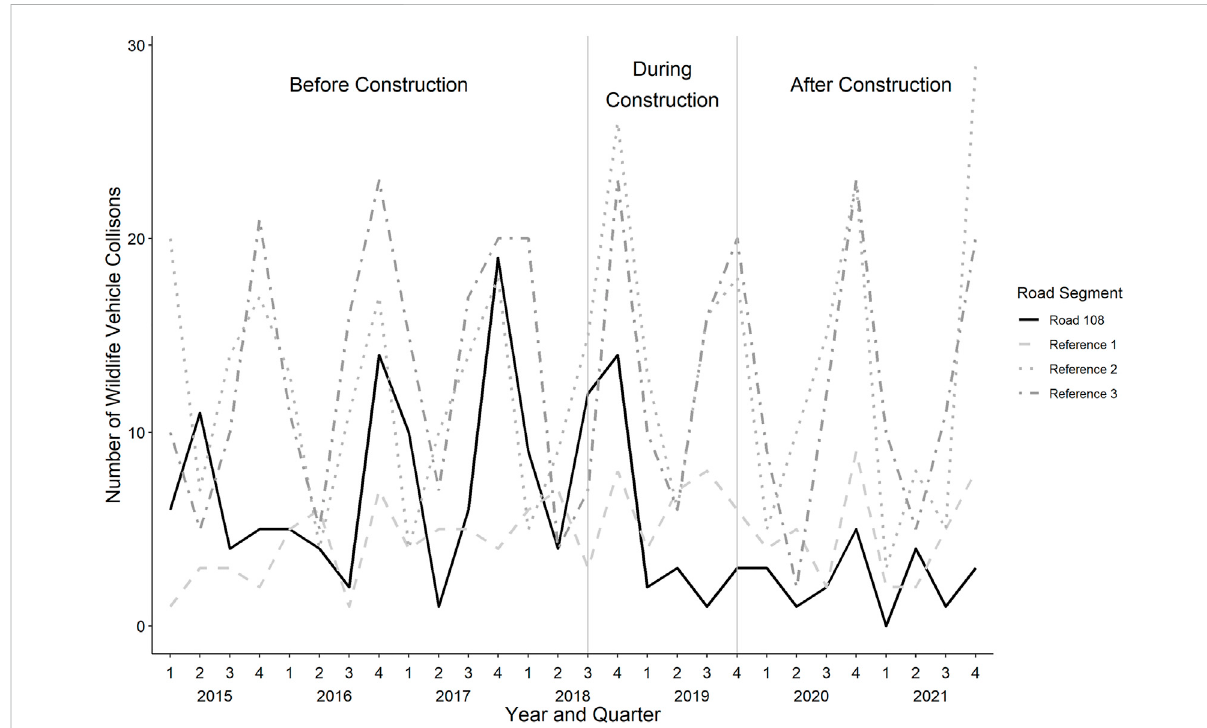
FIGURE 4 The number of wildlife vehicle collisions, summarized per quarter (i.e., Q1: January – March; Q2: April – June; Q3: July – September; Q4: October – December), from 2015 – 2021. The solid black line represents the road segment corresponding to the focal at-grade fauna passage. The